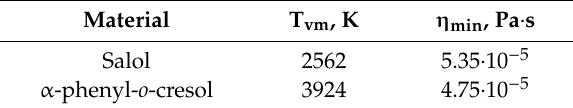
Table 3. Minimal theoretical